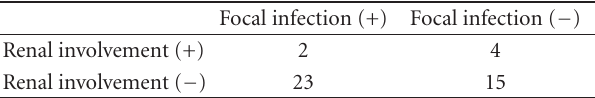
Table 1: Prevalence of renal involvement in total of 44 cases of HSP patients without nephritis at first examination.